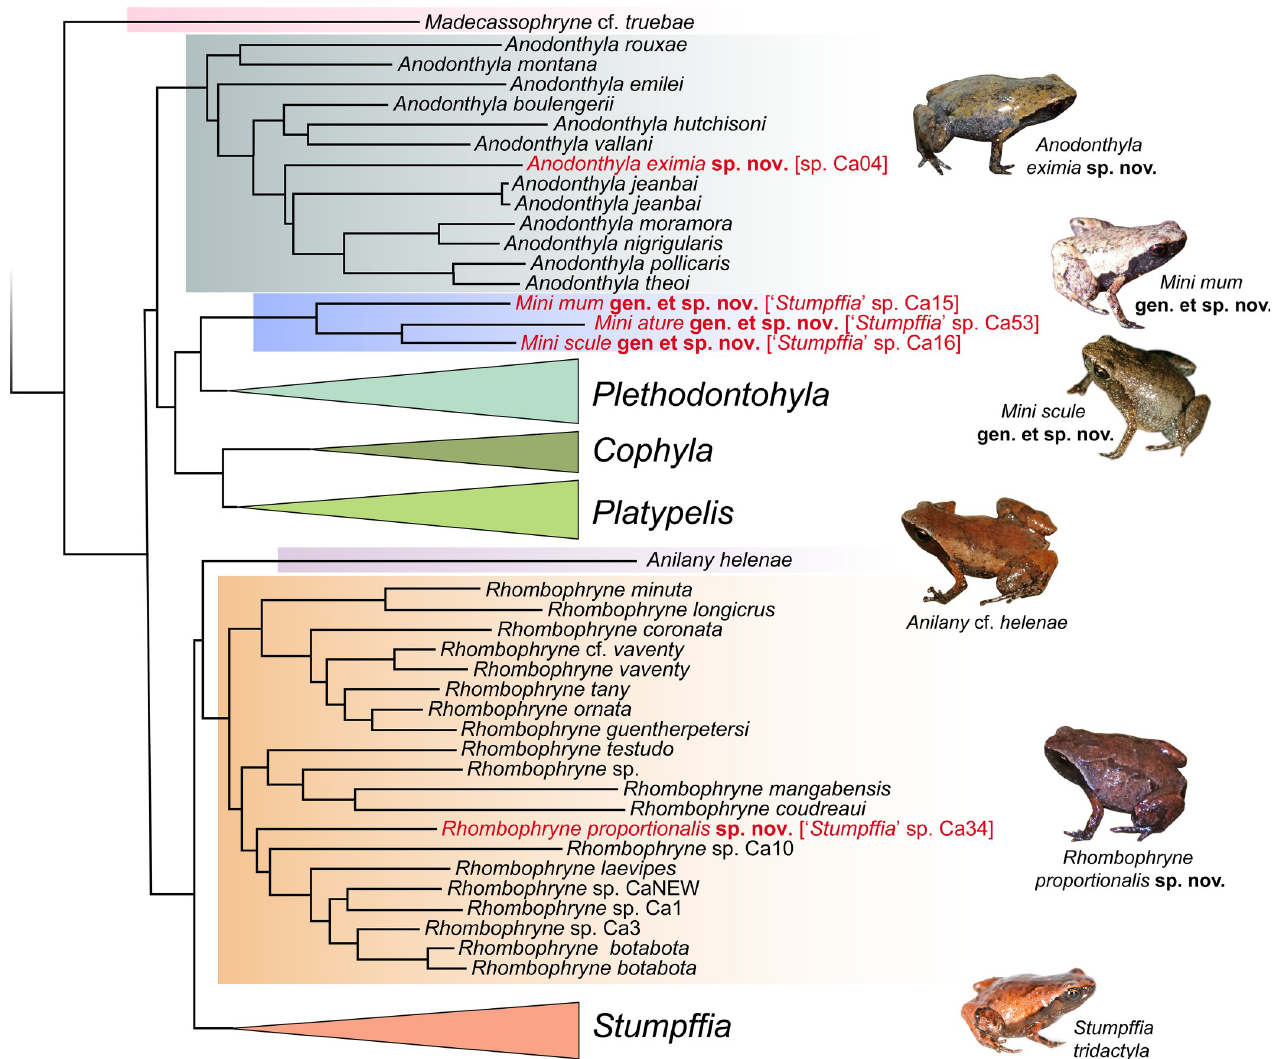
Fig 1. Stylised representation of the latest phylogeny of the microhylid subfamily Cophylinae. Based on the phylogenetic tree of Tu et al. [20] (reconstructed from a concatenated multi-gene DNA sequence data set) with numerous nomenclatural updates. See that paper for support values and phylogenetic context. The sister species of Rhombophryne proportionalis sp. nov. is an undescribed candidate species ( R . sp. Ca7) that is not included in this phylogeny; its taxonomy will be treated elsewhere. Taxa highlighted in red are those described herein. Inset photos show a selection of the new species described herein, and representatives of the other small-bodied genera, Stumpffia and Anilany . Inset photos are not to scale.